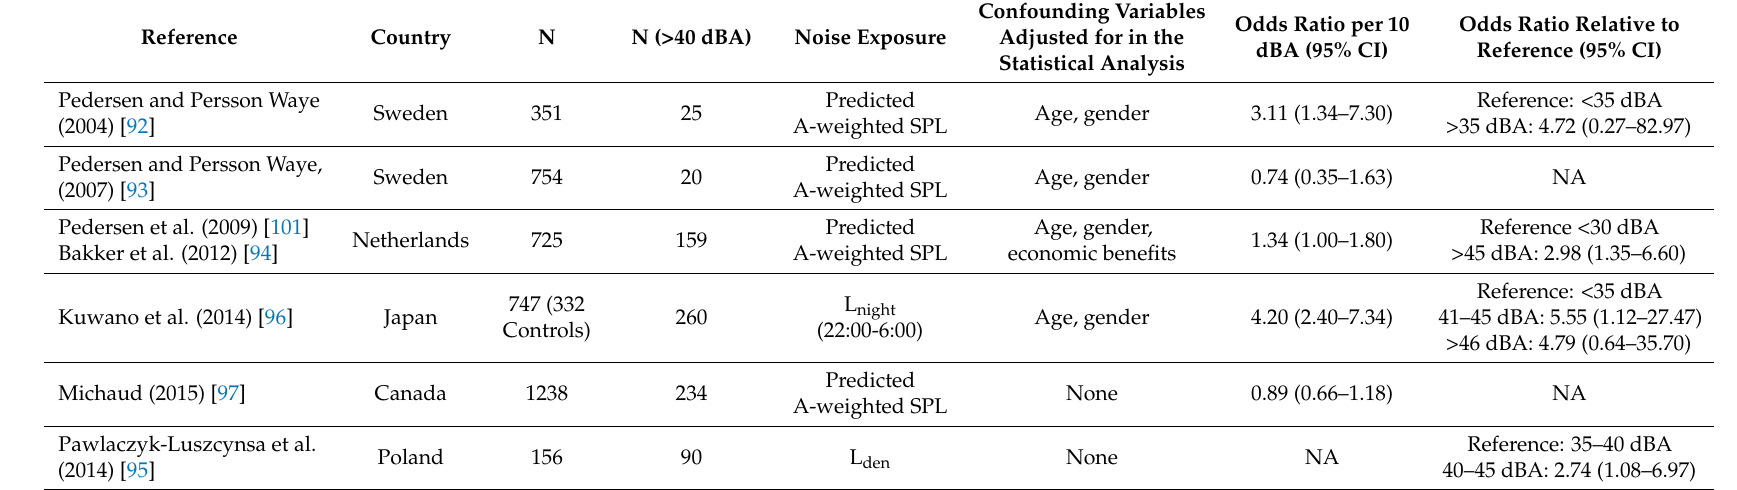
Table 7. Characteristics of studies on self-reported measures of sleep disturbance and wind turbine noise. Odds ratios for sleep disturbance are